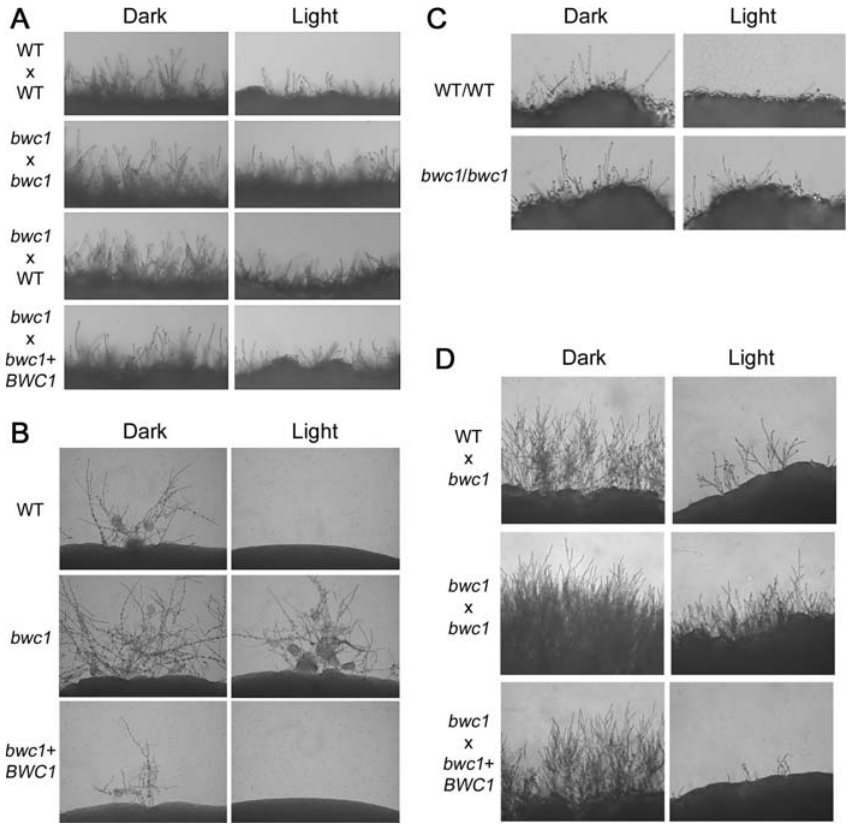
Figure 1. Bwc1 Inhibits Filament Formation during C. neoformans Mating or Haploid Fruiting Filamentation assays were on V8 medium (pH 7) and conducted in the dark or under white fluorescent light. (A) Filamentation in crosses between wild type (WT), bwc1 mutant, and bwc1 þ BWC1 reconstituted strains (48 h). Filament formation develops and is overgrown by yeast cells in wild-type or reconstituted strains crossed in the light. (B) Haploid fruiting filaments and blastospore production from yeast colonies incubated on filament agar (7 d). (C) Filament formation in wild-type (WT) or bwc1 / bwc1 mutant diploid strains (24 h). (D) Filamentation in crosses of serotype A strains wild type (WT), bwc1 mutant, and bwc1 þ BWC1 reconstituted strains mated with a serotype D bwc1 mutant (48 h). DOI: 10.1371/journal.pbio.0030095.g001 PLoS Biology |